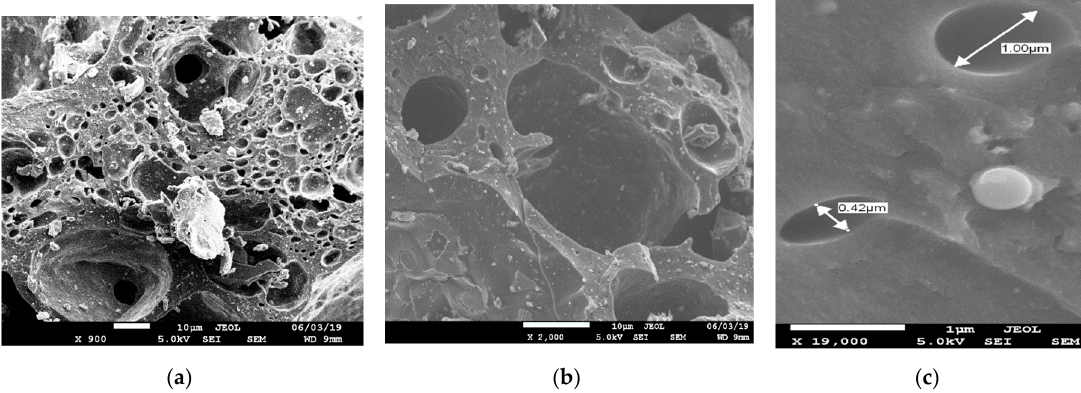
Figure 8. Surface morphology of the thermally-treated residual biomass of C. sorokiniana microalgae. expansion: ( a ) x 900, ( b ) x 2,000, ( c ) x 19,000